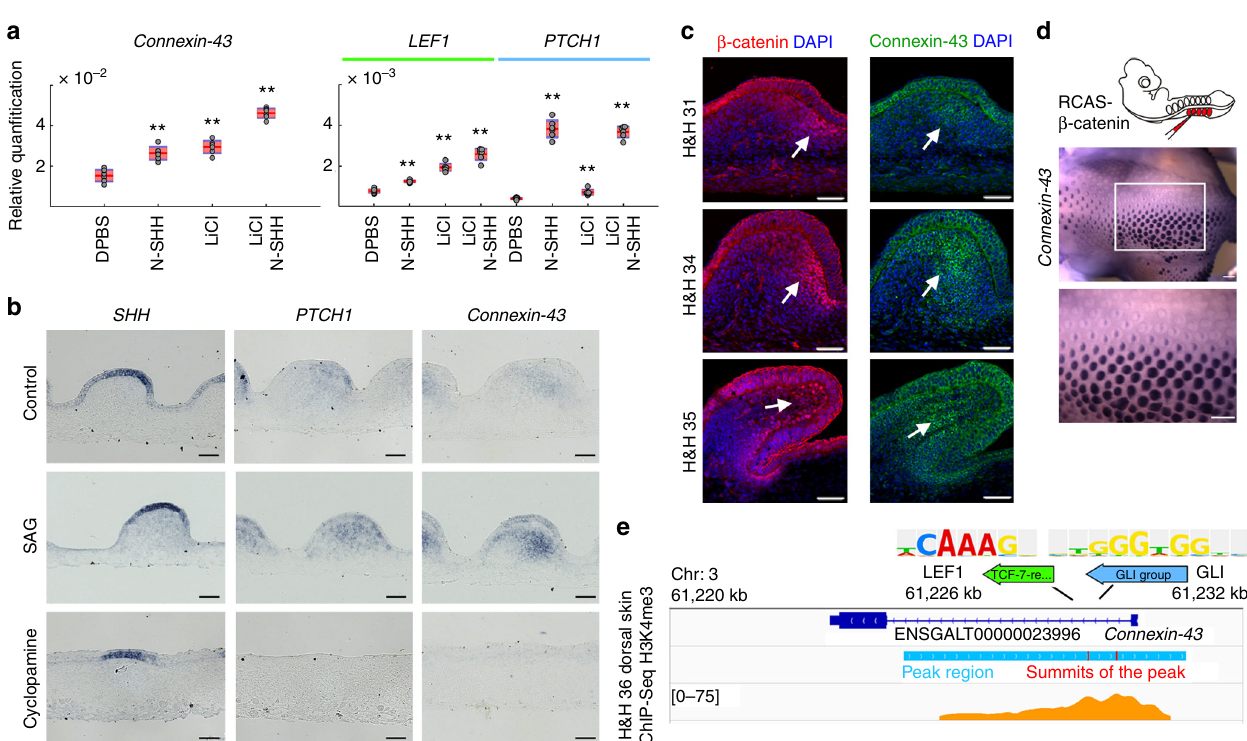
Fig. 8 SHH and WNT signaling synergistically activate Connexin-43 expression. a qPCR revealed a mild elevation of Connexin-43 expression in cultured mesenchymal cells treated for 24 h with 0.25 µ M SHH N-terminal peptide (N-SHH) or 7 mM LiCl to activate WNT signaling. The upregulation is more signi fi cant when both N-SHH and LiCl are present. Activation of SHH and WNT signaling are con fi rmed by PTCH1 and LEF1 qPCR, respectively ( n = 6). ** P < 0.01, two-sample Student ’ s t test. Customized boxplot: Mean (red) ± s.d. (pink), 95% con fi dence interval (violet). Dots denote individual data points. b In situ hybridization demonstrated higher Connexin-43 expression in feather buds treated with 500 nM SAG for 48 h. 5 μ M Cyclopamine treatment decreased Connexin-43 expression. Scale bar, 50 μ m. c Immunostaining revealed close proximity of the Connexin-43 positive zone and nuclear β -Catenin zone in feather mesenchyme. Scale bar, 50 μ m. d Mis-expressing constitutively active β -Catenin induced site-speci fi c elevation of Connexin-43 expression and abnormal feather polarity ( n = 5/5). The region magni fi ed is highlighted by rectangle. Scale bar, 500 µ m. e Motif search in the active promoter region